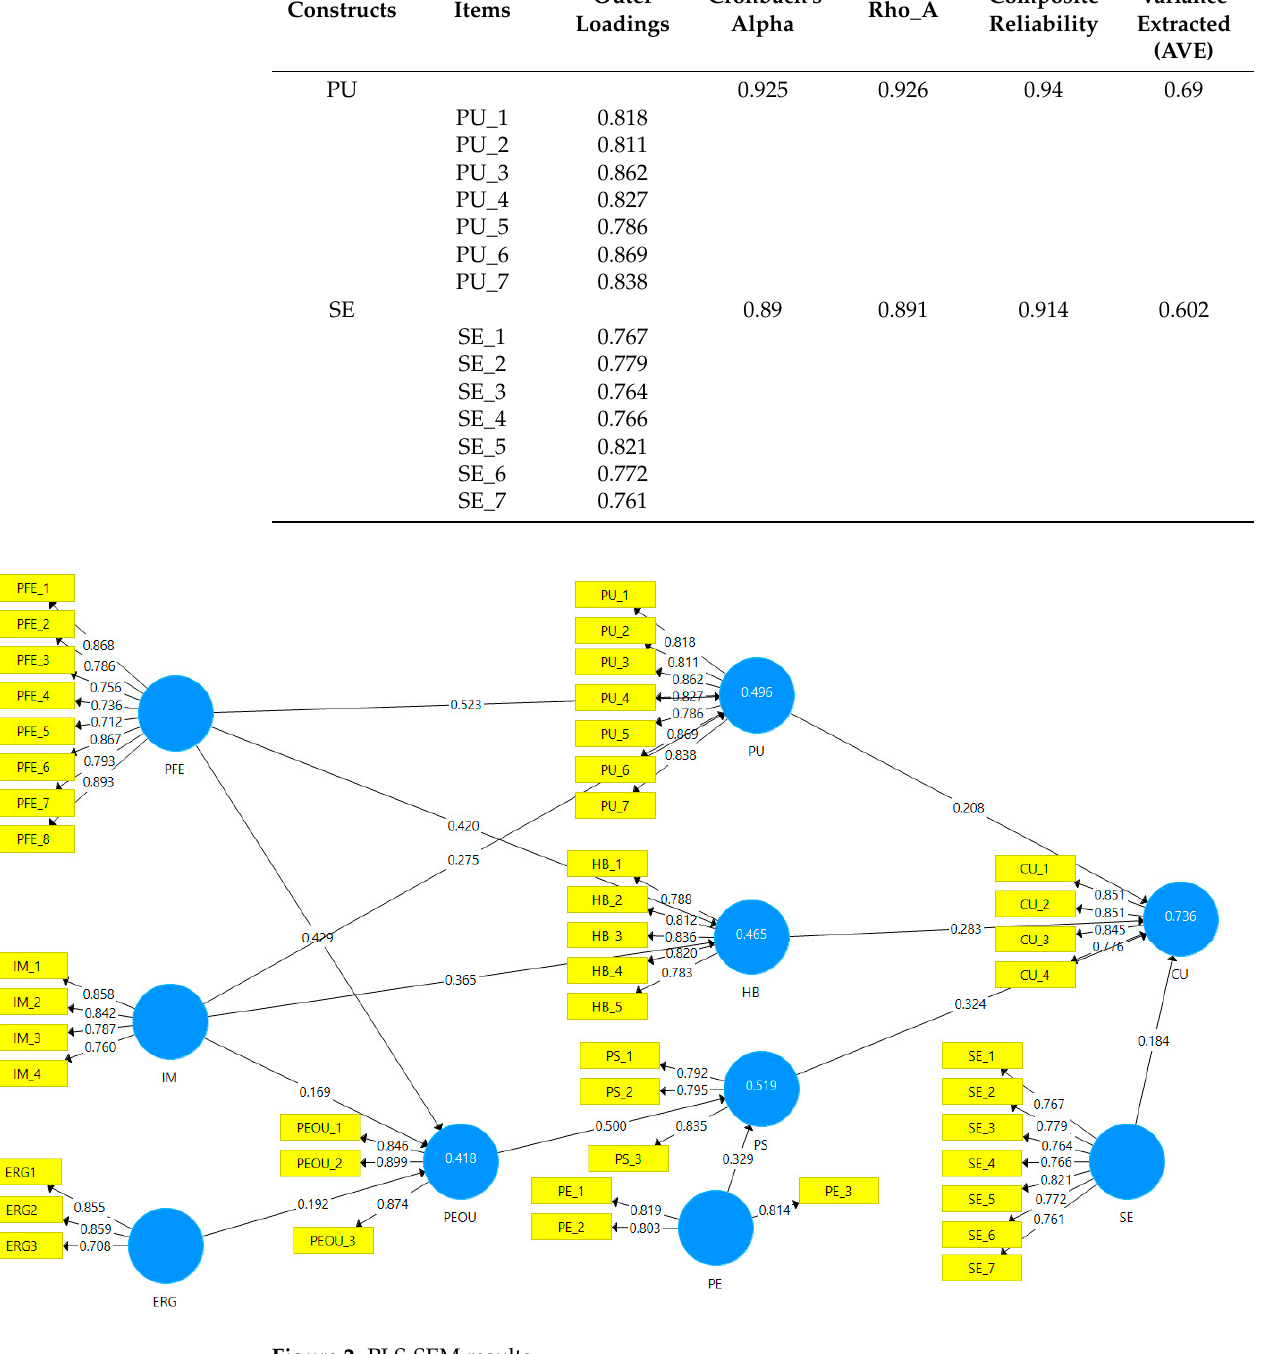
Figure 2. PLS-SEM results. One manner to fit discriminant validity is to use the Fornell-Larcker standard. Each number on the diagonal is more significant than the values on its column and row, meaning that we set discriminant validity (Table 3). Table 3. Fornell-Larcker standard study for investigating discriminant validity.